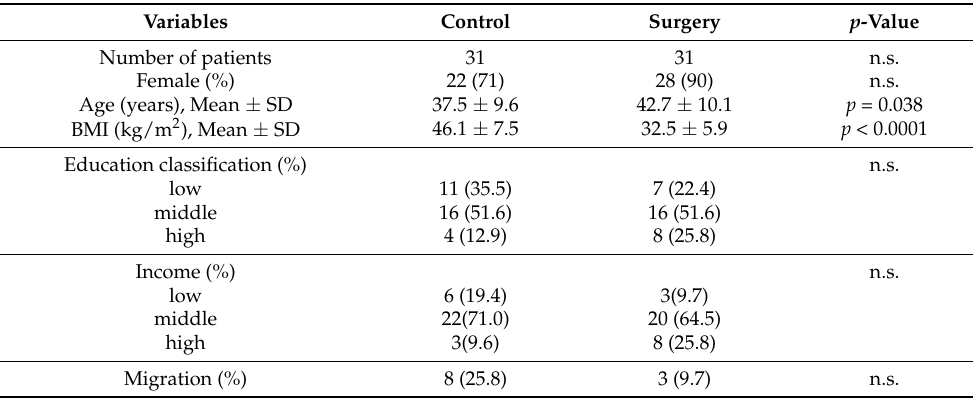
Table 2. Sociodemographic characteristics of 62